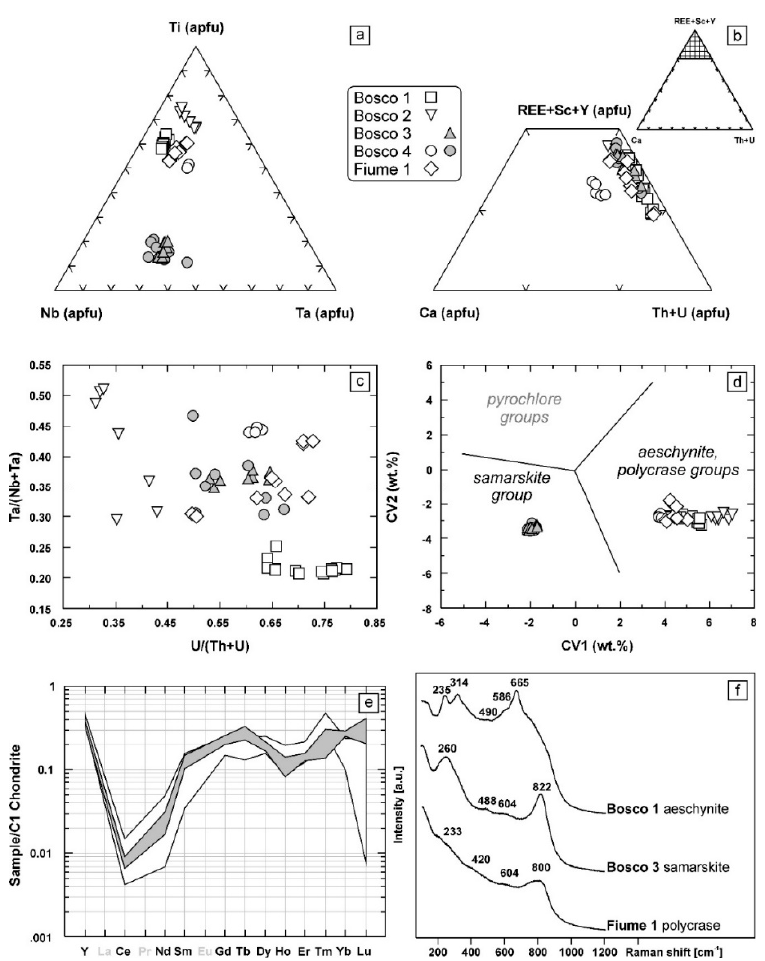
Figure 2. The composition of aeschynite-(Y), polycrase-(Y), and samarskite-(Y), plotted in terms of the Ti–Nb–Ta and (REE + Sc + Y)-Ca-(Th + U) apfu ternary plots are shown in ( a ) and ( b ). The quadrilateral plot of Ta/(Nb + Ta) and U/(Th + U) showing compositional variations of aeschynite-(Y), polycrase-(Y), and samarskite-(Y) are shown in ( c ). The CV2 versus CV1 Ercit [13] statistical diagram is shown in ( d ) and the chondrite versus normalized REE pattern of aeschynite-(Y), polycrase-(Y), and samarskite-(Y) from Arvogno is shown in ( e ). For all plots, aeschynite-(Y) and polycrase-(Y) are plotted in white and samarskite-(Y) in grey. Raman spectra of aeschynite-(Y) from Bosco1, samarskite-(Y) from Bosco3, and polycrase-(Y) from Fiume1 are shown in ( f ).